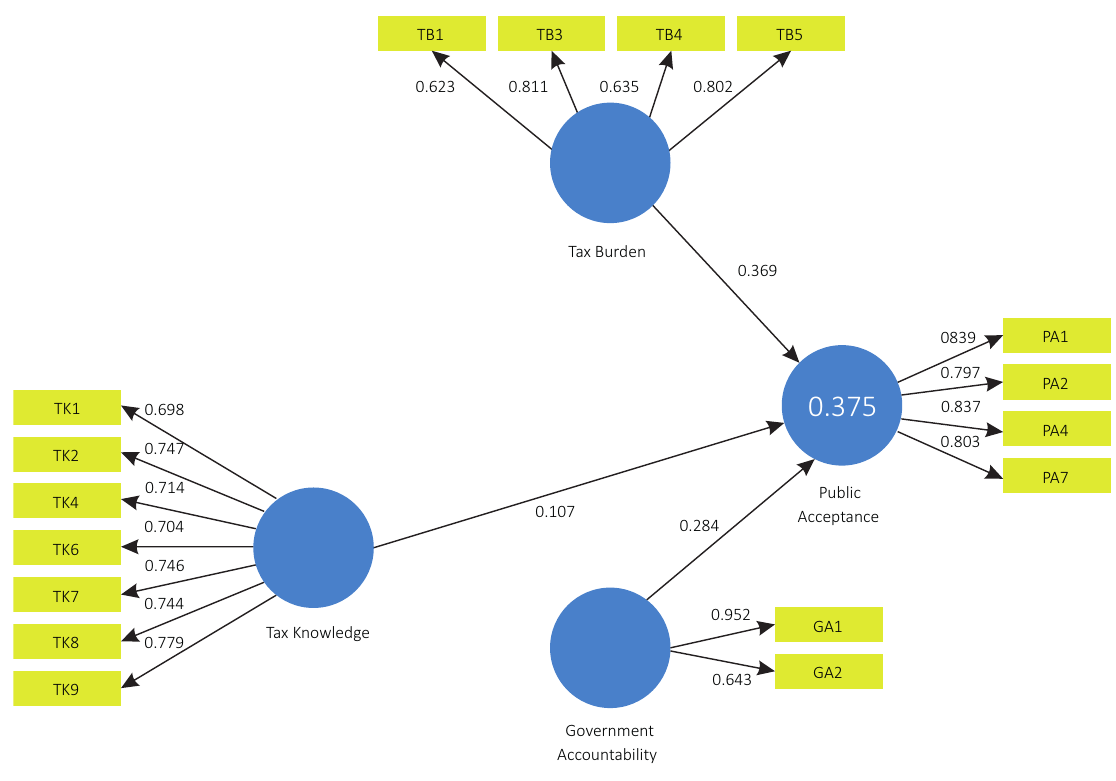
Figure 3. Assessing F-squared (f 2 ) effect size – tax fairness